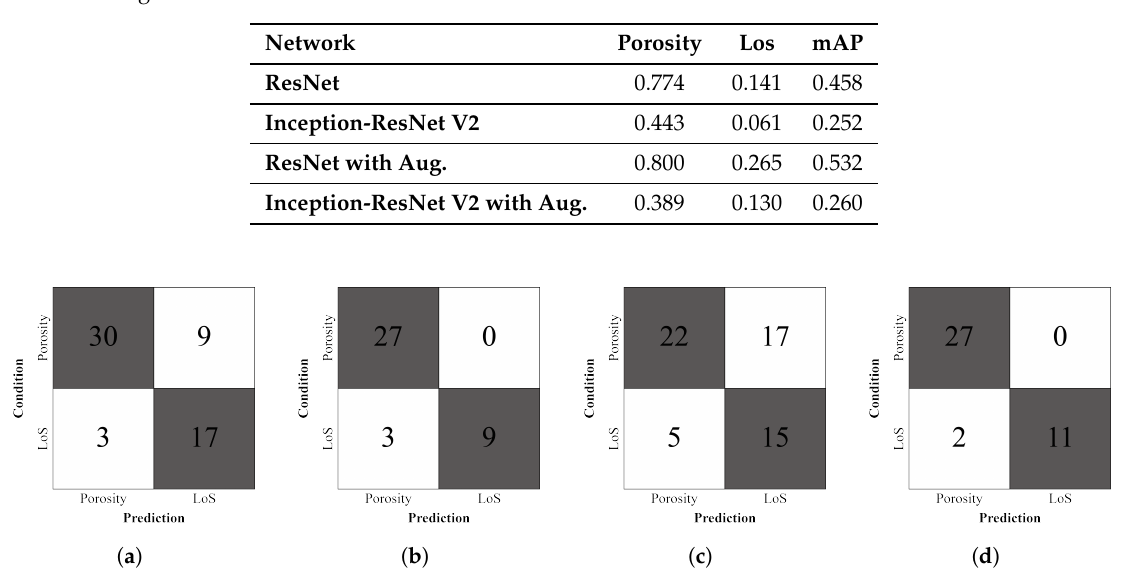
Figure 8. Prediction result. ( a ) ResNet ( b ) Inception-ResNet V2 ( c ) ResNet with Data augmentation ( d ) Inception-ResNet V2 with Data augmentation.